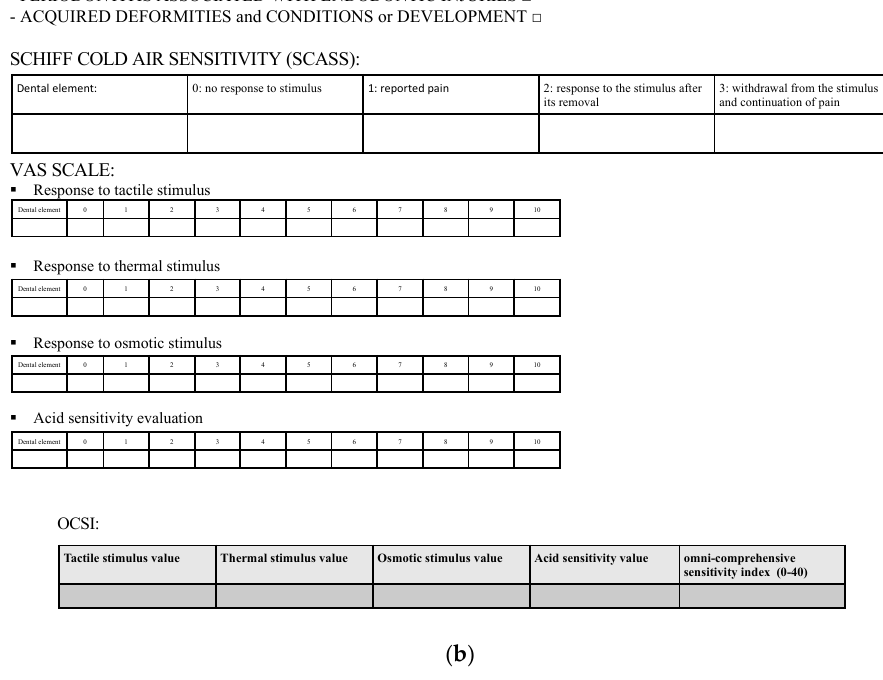
Figure 2. ( a ) Medical records used for each follow-up. ( b ) Periodontal health records and sensitivity test form used for each follow-up.